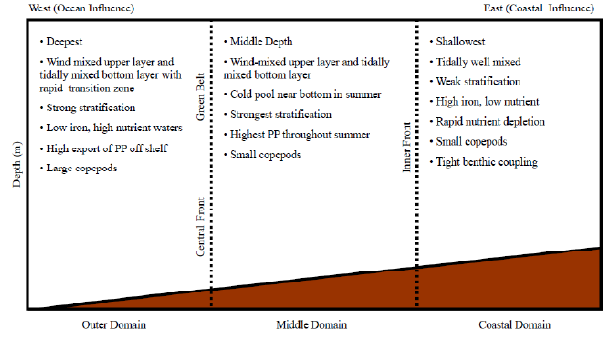
Fig. 2. Biogeochemical features of the Outer, Middle, and Coastal domains of the Bering Sea